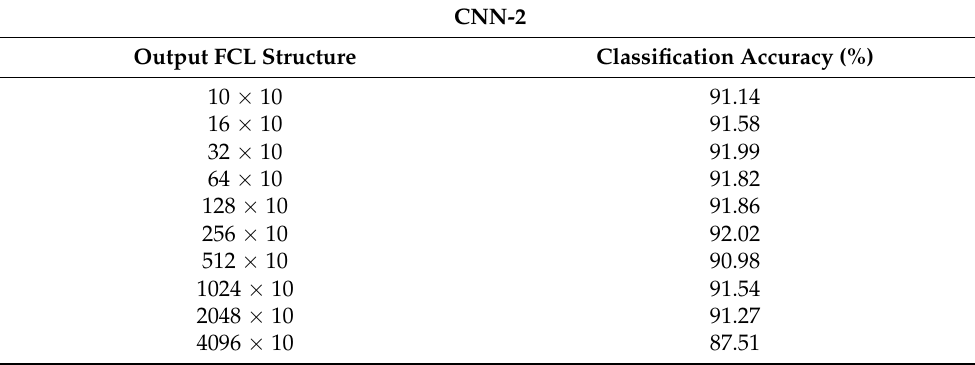
Table 1. Classification accuracy with various fully connected layer (FCL) structures.